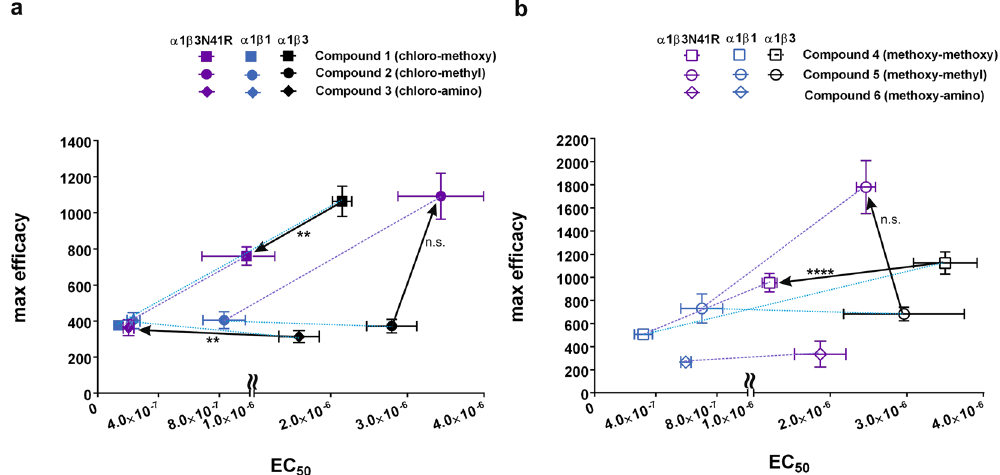
Figure 4. Comparison of EC 50 and maximum efficacy among α 1 β 1, α 1 β 3 and α 1 β 3N41R. ( a,b ) The plots show the mean EC 50 on the x-axis (note that the axis is broken to accommodate the range) and the mean maximum efficacy at 10 μ M (% of control current at EC 3–5 ) on the y-axis (note the different scales on the two panels) of compounds 1 – 6 . The difference between wild type α 1 β 3 and α 1 β 3N41R is indicated with a black arrow, statistically significant EC 50 differences are indicated. The potency differences between α 1 β 3 and α 1 β 3N41R for compounds 1 , 3 and 4 are statistically significant ( ** , ** , ****, respectively). Arrows pointing to the left show a decrease of the EC 50 value between wild type and mutated receptors, which corresponds to an increase in potency. Simultaneously, changes in efficacy can be seen (arrows with upward or downward component indicating increase or decrease in maximum efficacy, respectively). The values obtained with wild type α 1 β 3 and α 1 β 1 receptors are connected with a blue dotted line. The dotted purple line visualizes the difference between α 1 β 1 and α 1 β 3N41R. The EC 50 values for the mutated receptors are 0.98 µ M, 3.44 µ M, 0.2 µ M, 1.2 µ M, 2.47 µ M and 1.87 µ M for compounds 1 – 6 , respectively. EC 50 values were calculated for each individual experiment and are presented as mean ± SEM. Statistically significant differences were assessed by one-way ANOVA with Tukey’s multiple comparison test. Note that the EC 50 value of compound 6 in α 1 β 3 receptors is not depicted, since this compound has nearly no efficacy in this receptor subtype. Bars indicate mean ± SEM, n = 3–8. The dose-response curves of compounds 1 – 6 in α 1 β 3N41R receptors are depicted in Supplementary Fig. S12.